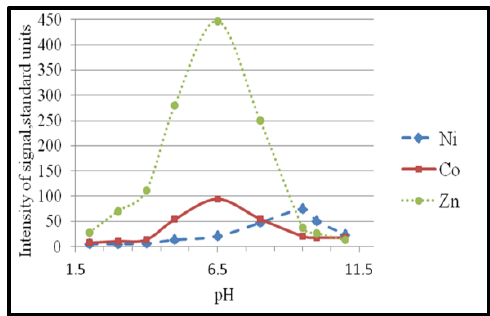
Figure 2. Selection of pH for trace metal sorption concentration (intensity of signal is average for all types of sorbent).